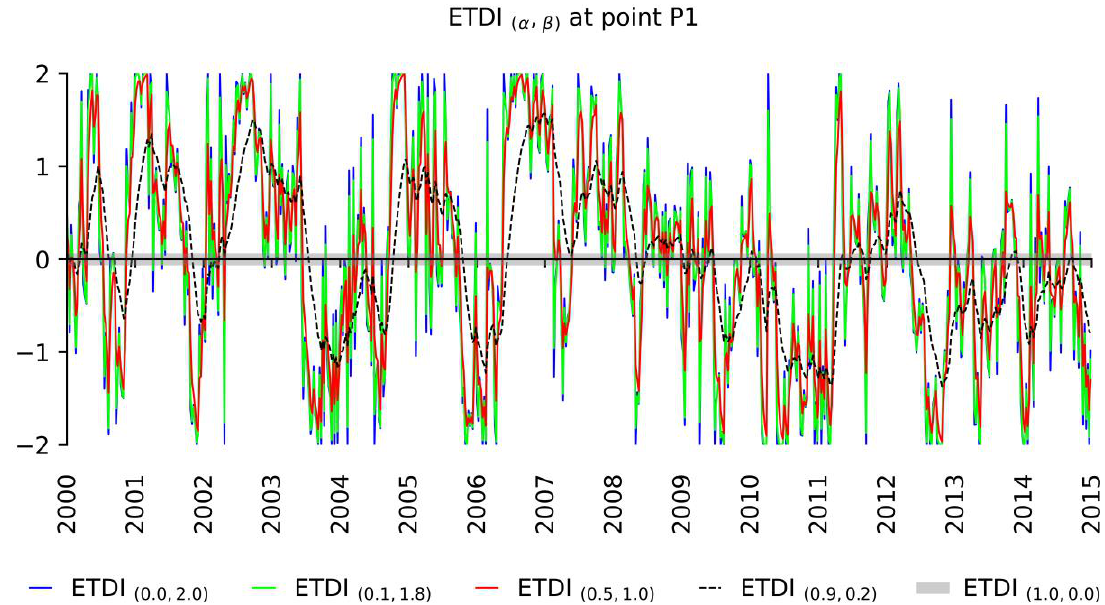
Figure 4. The 8-day evapotranspiration deficit index (ETDI) for five different ( α , β )-parameter combinations at point P1 in the Ruvu River basin.